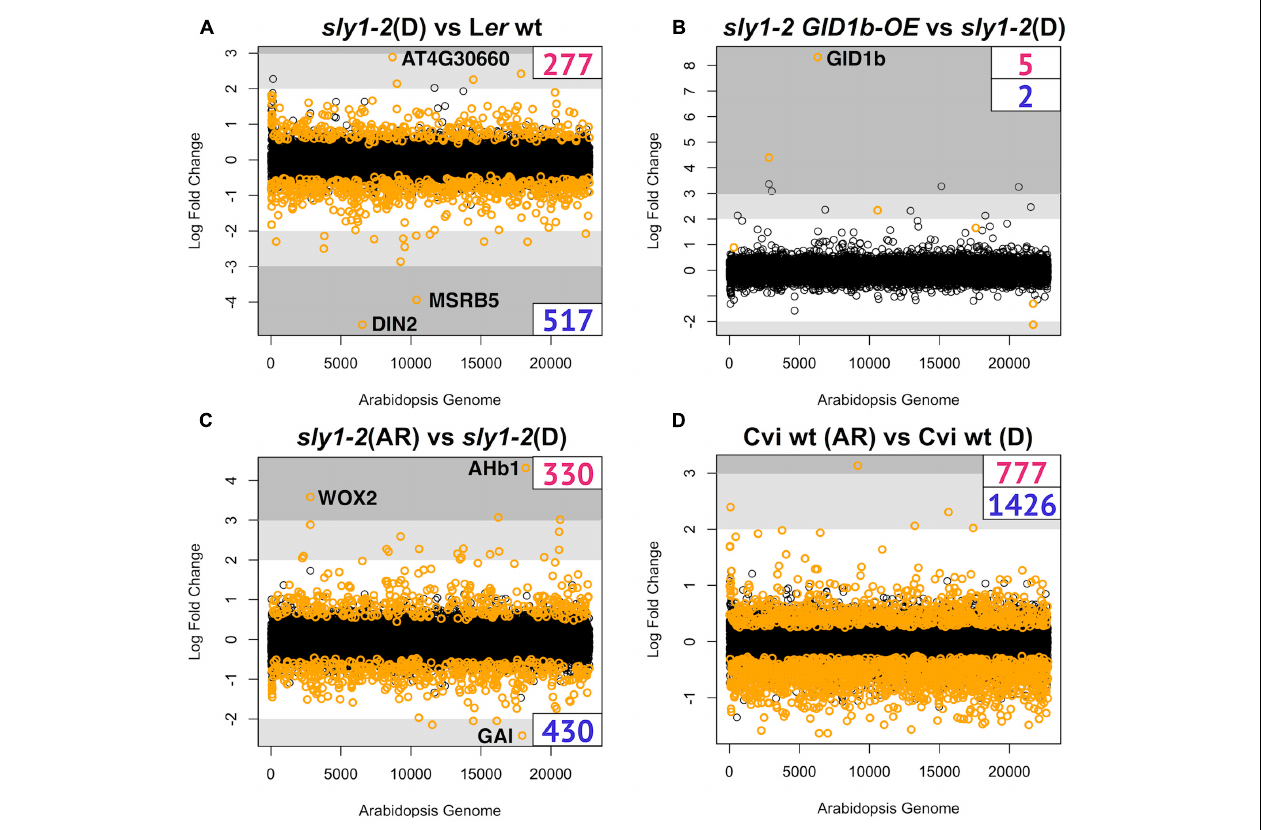
FIGURE 2 | Genome wide expression plots. Plots indicate skew, chromosomal distribution, and magnitude of (A) dry seed sly1 -regulated transcriptome differences, (B) dry seed sly1-2 GID1b-OE vs. sly1-2 (D) differences, (C) differences after-ripened (AR) and dormant (D) sly1-2 dry seeds sly1-2, and (D) differences between after-ripened (AR) and dormant (D) Cvi. Genes with significant differences are indicated in orange (based on FDR p < 0.05). Up-regulation is indicated by positive log 2 -fold change (logFC) and down-regulation with negative. Shaded area mark the ± 2 and ± 3 logFC to allow comparison of magnitude and skew between